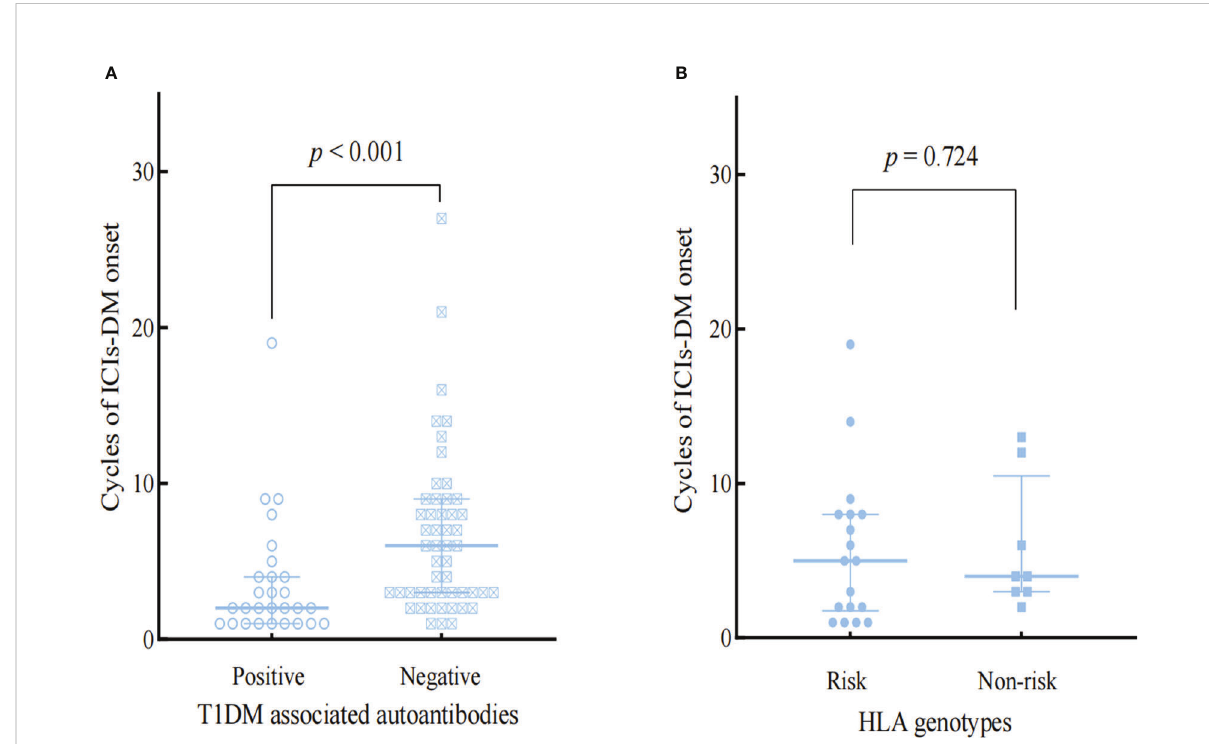
FIGURE 2 Comparison the in fl uences of T1DM-associated autoantibodies (A) and HLA genotypes (B) on the onset of